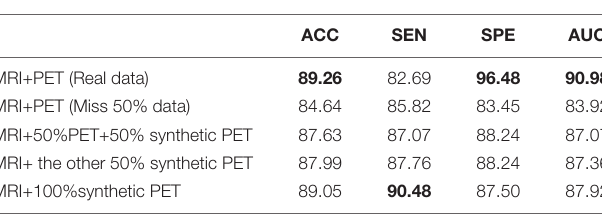
TABLE 4 | Results (%) of the models trained from only PET data for CN vs. AD task. Model ACC SEN SPE AUC 3D-VGG11 (Huang et al., 2019) Bold values mean the best value in the comparative experiment.